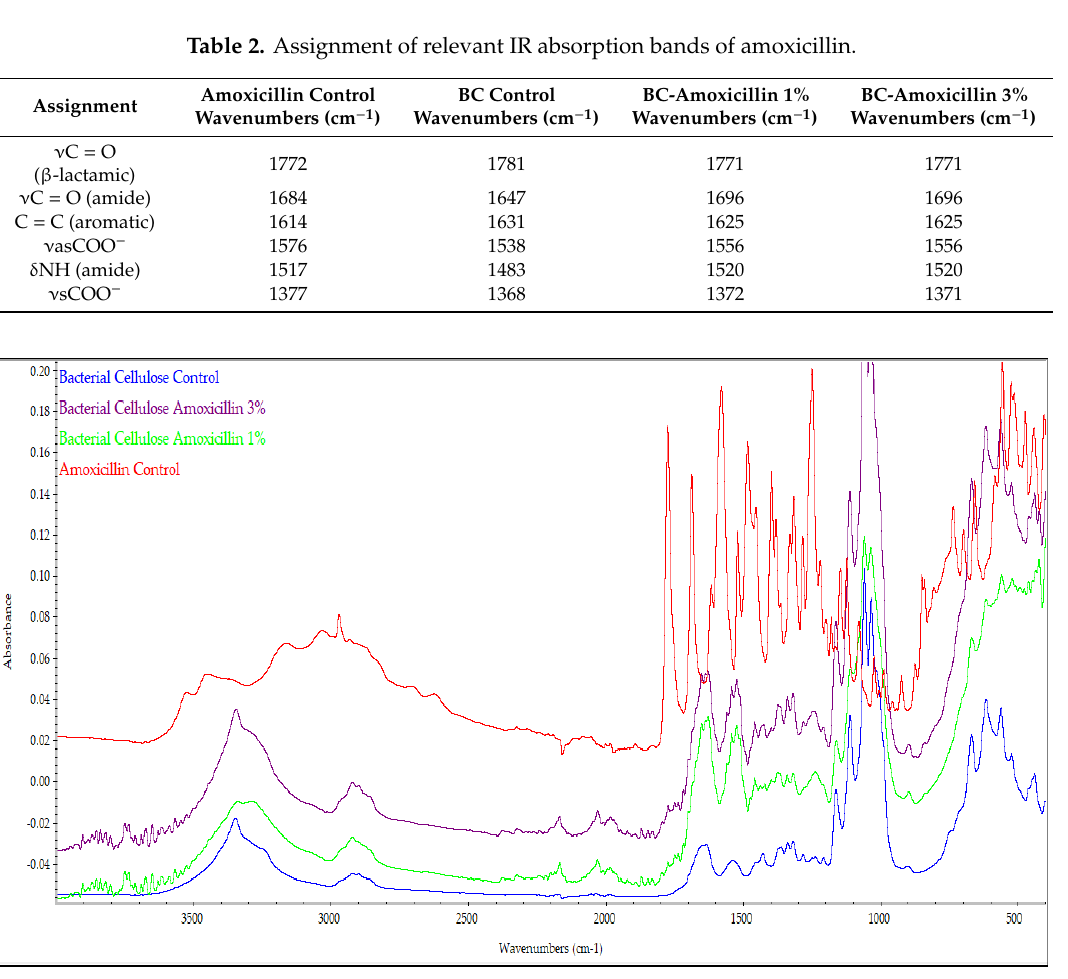
Figure 3. FTIR spectra for BC control, BC-amoxicillin 1%, BC-amoxicillin 3%, and amoxicillin Table 2. Assignment of relevant IR absorption bands of amoxicillin.